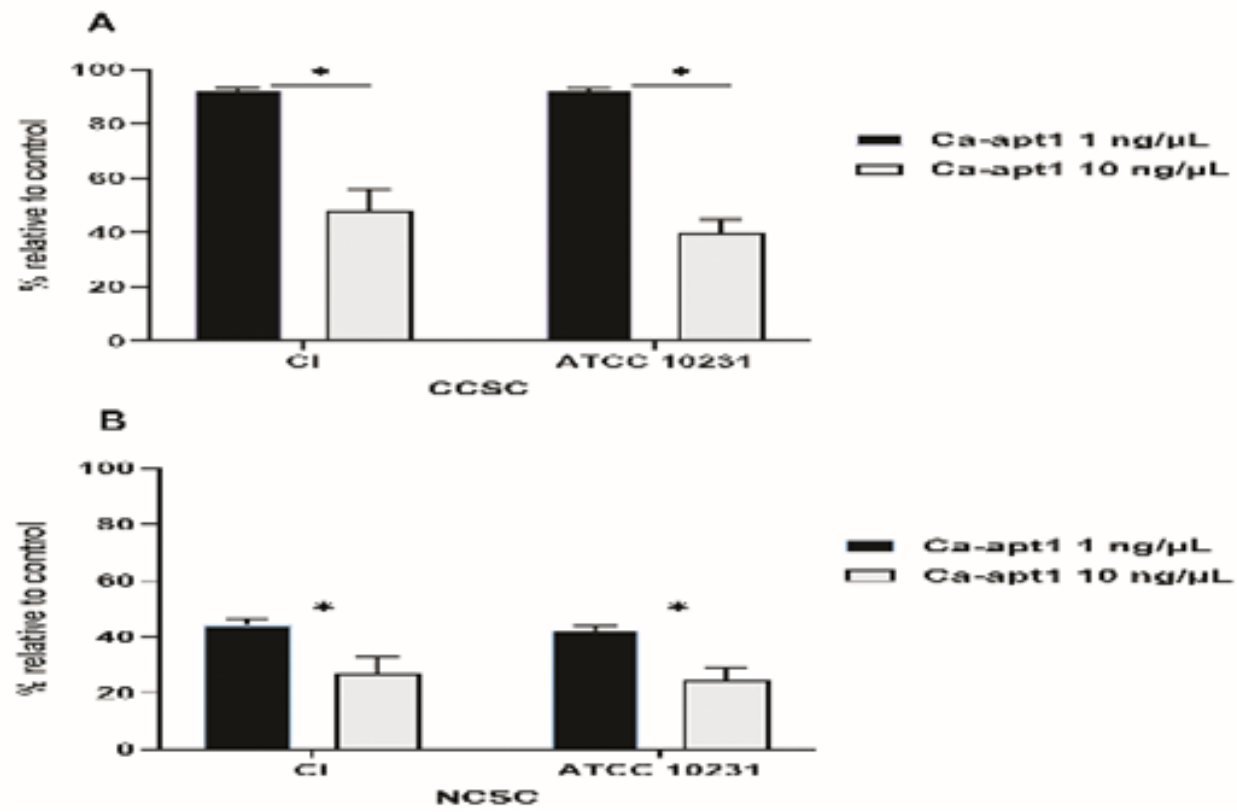
Figure 4. Effect of condensate smoke on preformed biofilm cells. The effect of CCSC ( A ) and NCSC ( B ) exposure on biofilm formation of C. albicans, which had been precoated with different concentration of Ca-apt1, evaluated after incubation for 48-h. The relative biofilm formation compared to biofilm without the precoating aptamer (control) was calculated. Data represent the mean and standard deviation (SD) of three biofilms grown on two separate occasions. Asterisks denote statistically significant differences between the effect of cigarette smoke condensate determined by MTT assay, p < 0.05. The CCSC and NCSC are clove and non-clove cigarette smoke condensate,